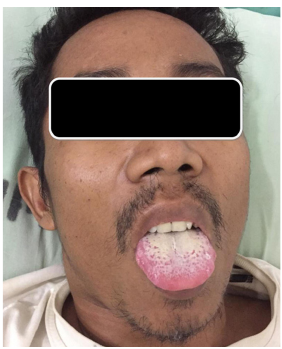
Fig. 2. Clinical picture of the subject on the first day